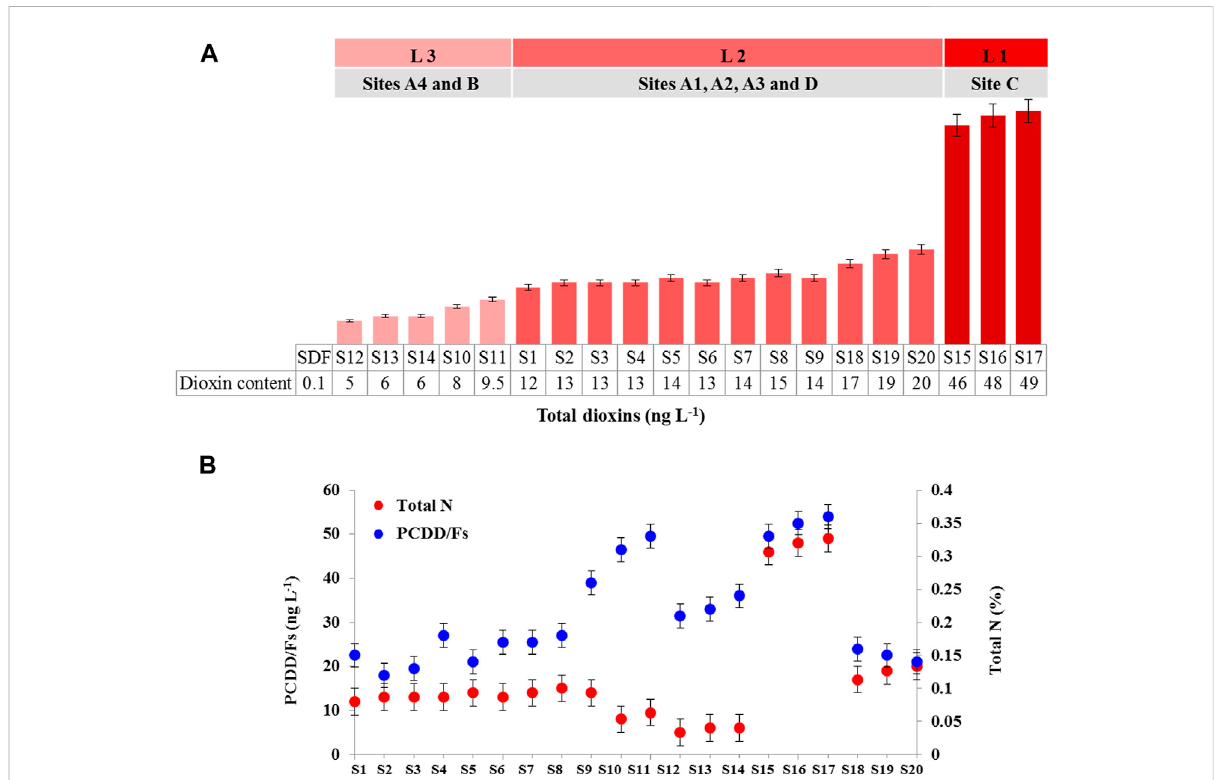
FIGURE 1 Level of PCDD/Fs in soil samples. (A) PCDD/Fs were extracted from soil samples and the total PCCD/Fs in each sample was determined by a PCDD/Fs-speci fi c ELISA kit. Dioxins levels in soil samples were categorized into three levels; level L 1 (~50 ng L − 1 ), the level L2 (from 12 to 20 ng L − 1 ), andlevelL3(from5to~10 ngL − 1 ). (B) TherelationbetweenthetotalnitrogencontentinsoilsamplesandtheirlevelsofcontaminationwithPCDD/Fs. All measurement were done in triplicate. Values are means ± S.D ( n =